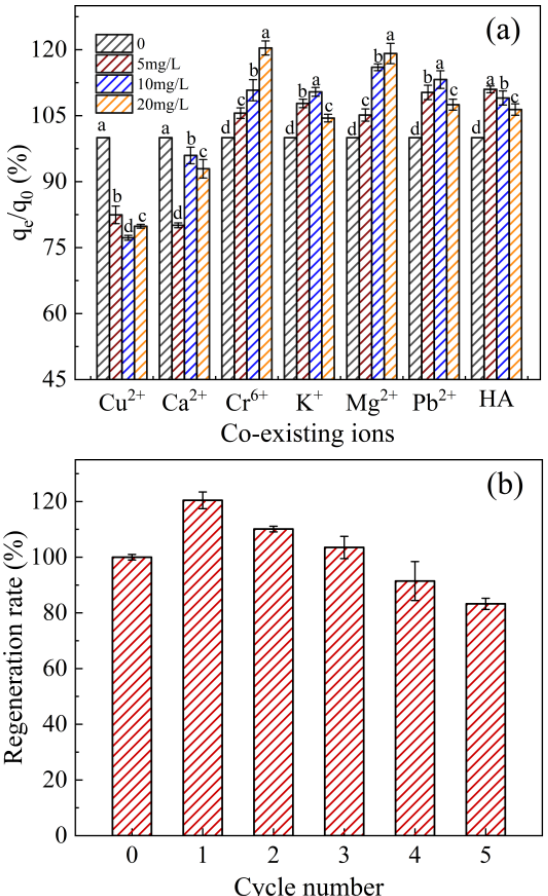
Figure 6. Effects of coexisting substances and reusability of WHCBC: ( a ) effects of coexisting ions (Cu 2+ , Ca 2+ , Cr 6+ , K + , Mg 2+ , Pb 2+ ) and HA on TE removal; ( b ) regeneration rate of WHCBC. Different letters indicate significant differences between the different concentrations of coexisting substances at the 0.05 level, tested by one-way